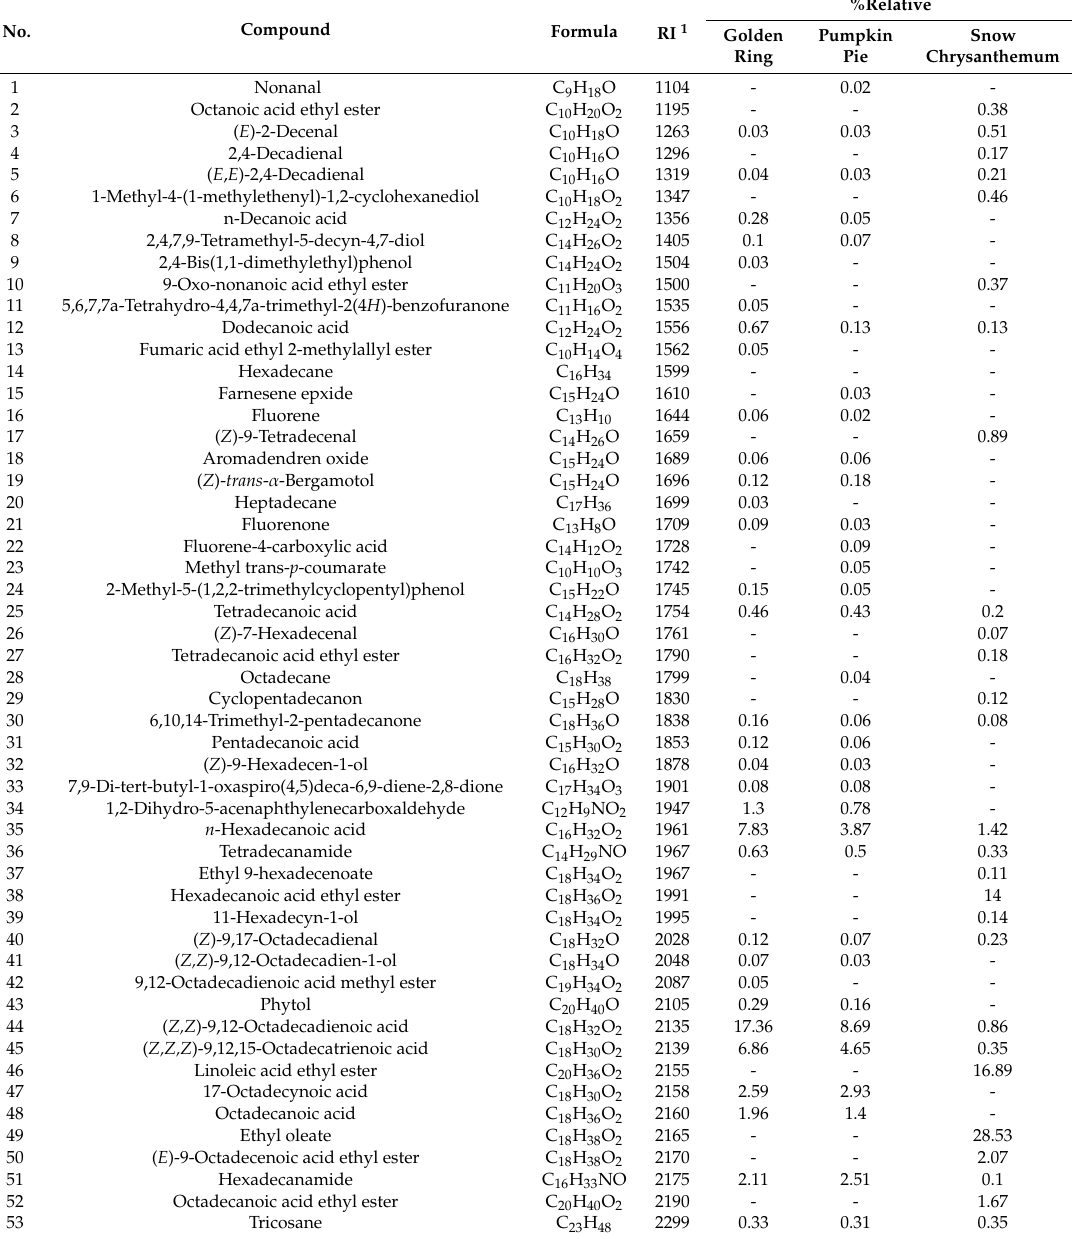
Table 1. Composition of volatile compounds of the dichloromethane extracts obtained from “golden ring”, “pumpkin pie” and “snow